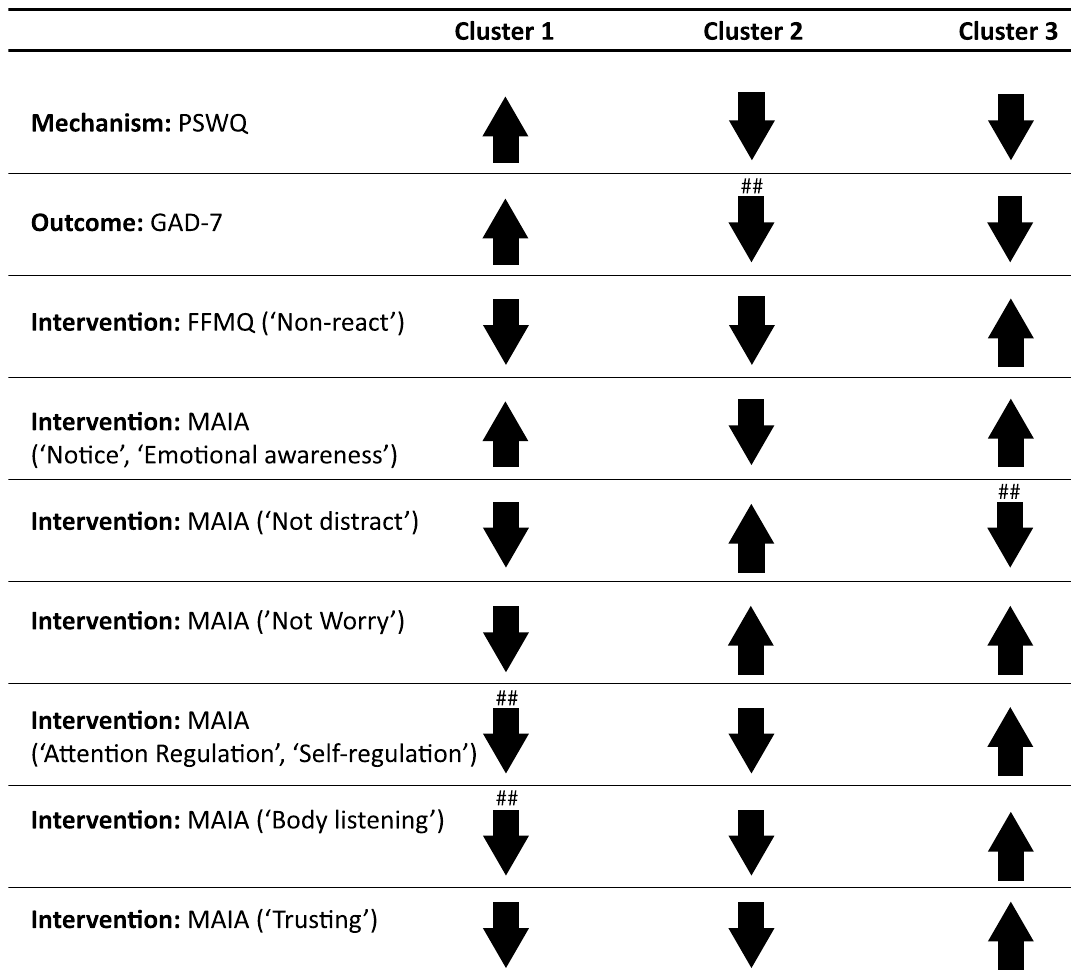
Table 3. Study 2 cluster description of individual questionnaire items. Questionnaires’ subscales are listed in parentheses when applicable. 95% confidence intervals for each item’s within-cluster average were computed: Full upward arrows indicate that the within-cluster z-score average for the scale/subscale’s items was positive and that > 50% of items had confidence intervals that exceeded the group mean. Full downward arrows indicate that the within-cluster z-score average for the scale/subscale’s items was negative and that > 50% of items had confidence intervals that preceded the group mean. ## Indicates that the direction of > 50% scale/subscale’s items relative to the group mean was distinct between Studies 1 and 2. PSWQ: Penn State Worry Questionnaire; GAD-7: Generalized Anxiety Disorder 7-item Scale; FFMQ_NR: Non-Reactivity Subscale of the Five Facet Mindfulness Questionnaire; MAIA: Multidimensional Assessment of Interoceptive